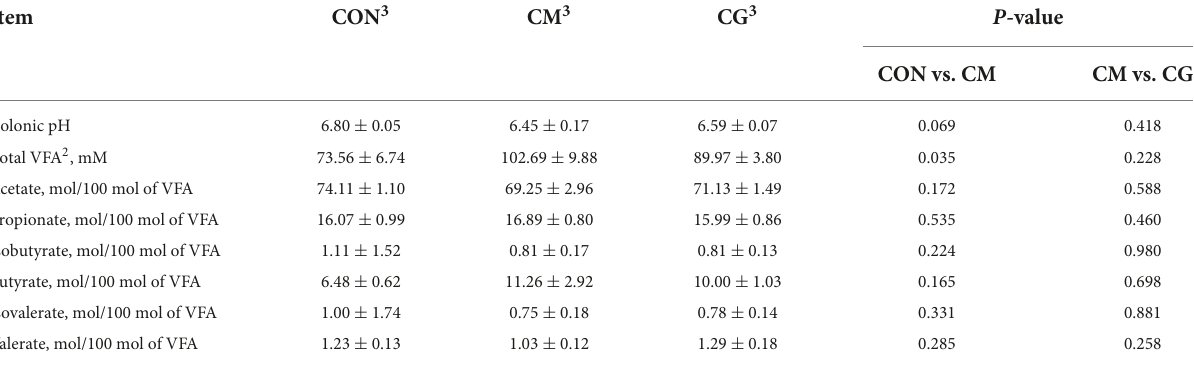
TABLE 1 The effect of CON, CM, and CG on colonic fermentation parameters of weaned lambs 1 . Item CON 3 CM 3 CG